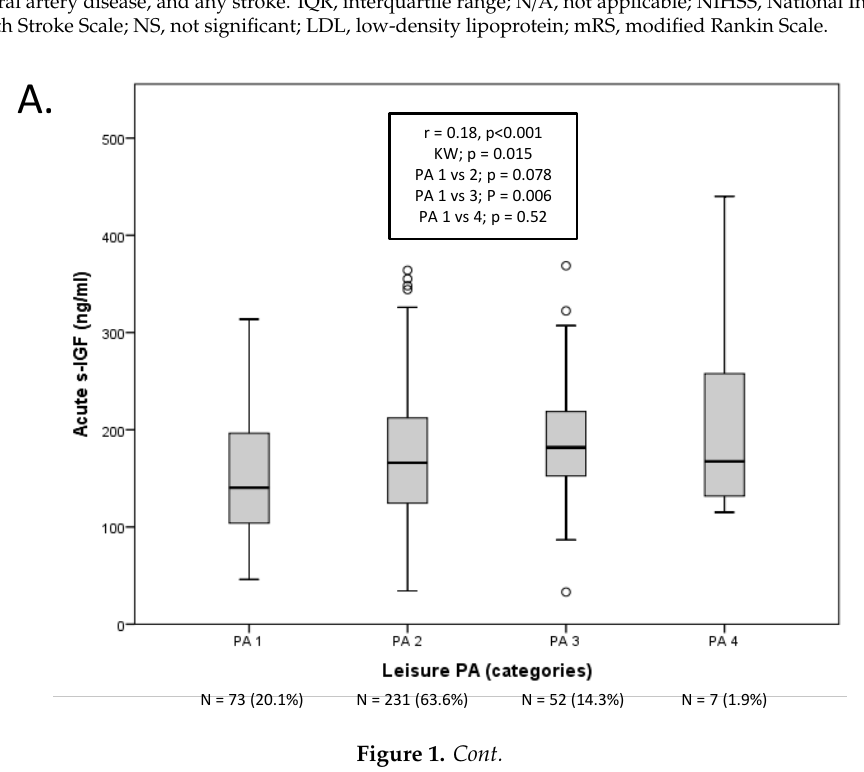
Figure 1. Serum insulin-like growth factor I insulin-like growth factor I (IGF-I) (ng/mL) according to pre-stroke physical activity (PA) levels 1-4, as assessed by Salting-Grimby. ( A ). Baseline IGF-I according to pre-stroke PA. ( B ). ΔIGF-I, according to pre-stroke PA. ΔIGF-I represents the change (decrease) in serum IGF-I (s-IGF-I) from baseline to 3 months post-stroke. Thus, a greater positive value in the figure represents a greater decrease. Box plots showing the median, interquartile ranges, whiskers, outliers (circles) and extremes (asterisks, see methods). The results of the Spearman correlation are given in the text box (rho, r , and p -values). The Kruskal–Wallis (KW) overall p -value is given as well as p -values for the Bonferroni-corrected (for 3 comparisons) comparisons vs. PA1. For baseline s-IGF-I, there were N = 363 (95.5%), and for ΔIGF-I, there were N = 334 (87.8%), with numbers ( N ) and relative percentages (%) for each PA1-4 category given in the Figure.